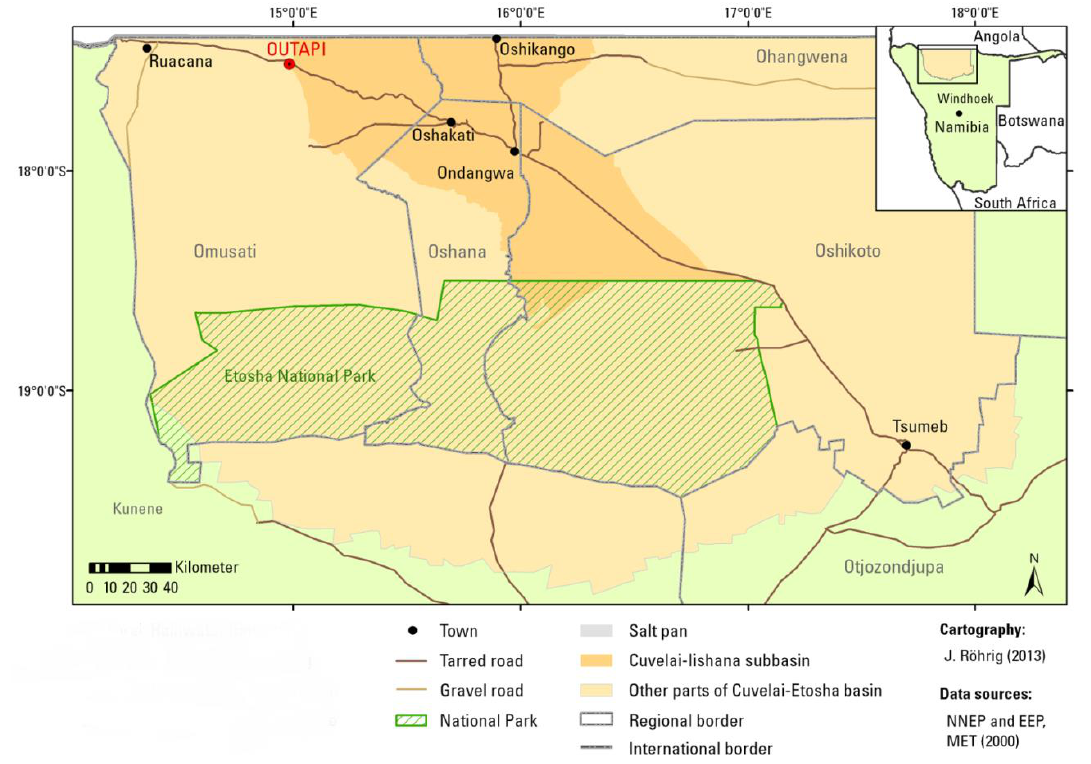
Figure 1. Map of central northern Namibia (map by J. Röhrig, 2013, modified).